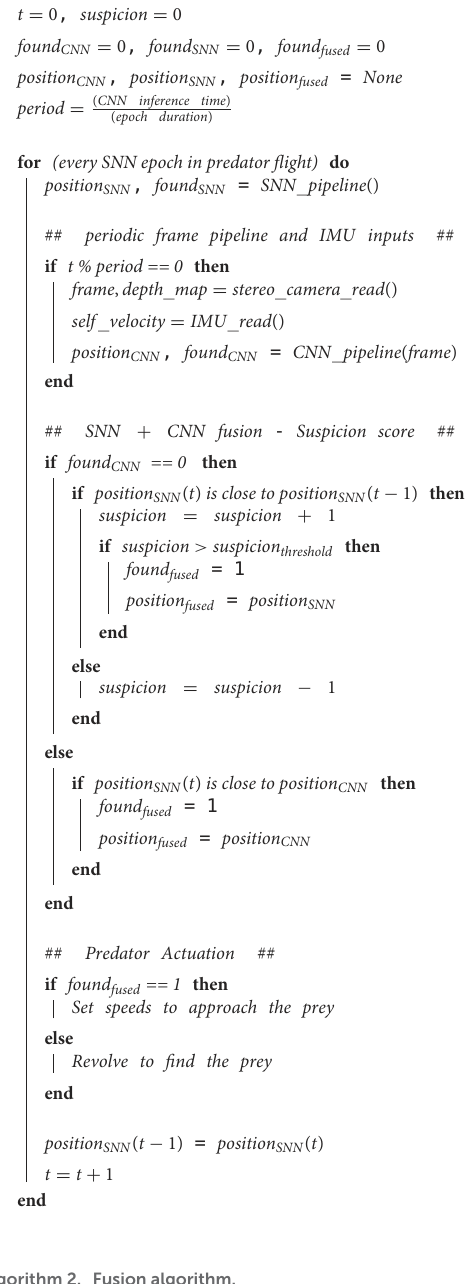
Algorithm 2. Fusion